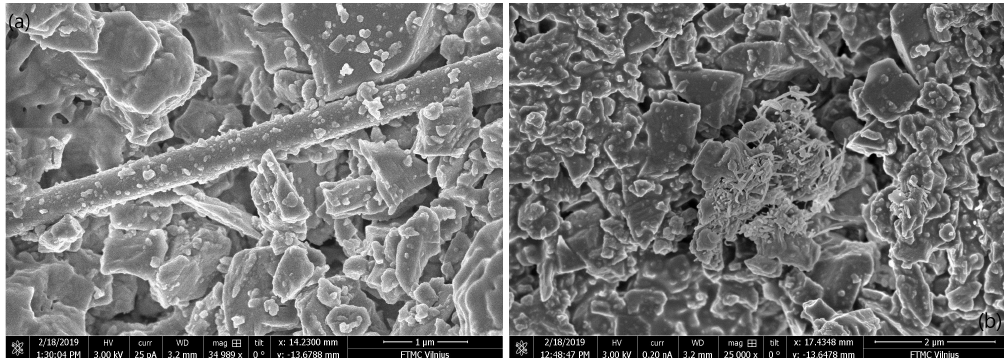
Figure 1. Scanning electron microscopy of the sample: SiC whiskers ( a ) and ( b ) MWCNTs embedded into phosphate